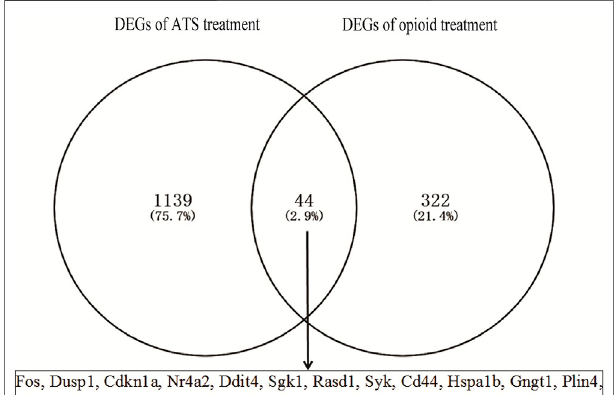
FIGURE 3 | The coexpressive differentially expressed genes (CDEGs) in ATS- and opioid-treatment databases by Venn diagram.